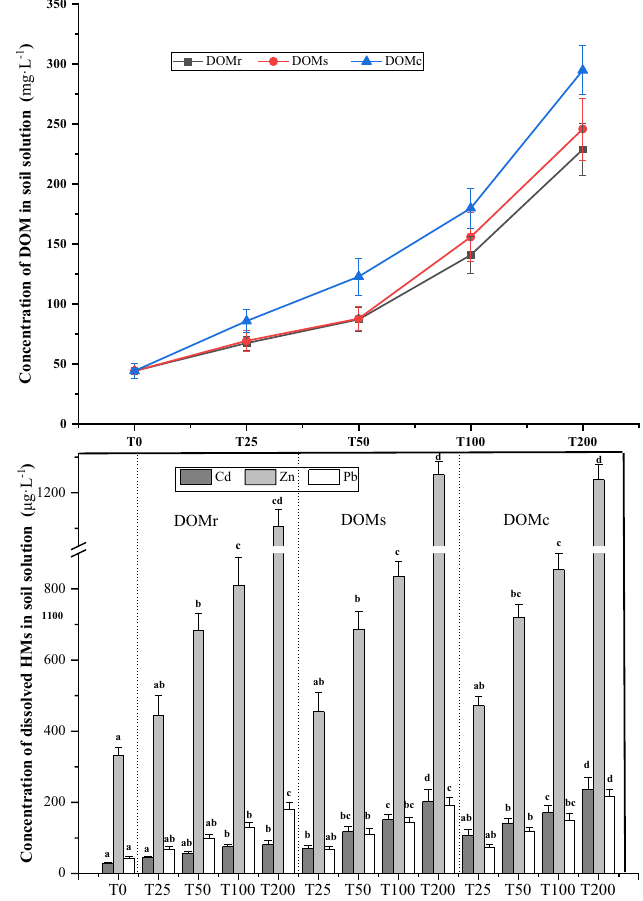
Figure 1. Concentrations of HMs (μg L −1 ) and DOC (mg L −1 ) in soil solution. The lowercase letters refer to significant difference among the treatments for the same HM at 0.05 level. T0, T25, T50, T100, T200 represented for the control, and the treatment of amending with four levels of each DOM at 25, 50, 100, 200 mgC kg −1 soil,